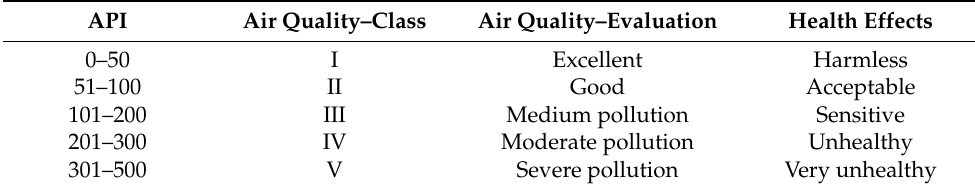
Table 4. Air pollution index (API) limit values.